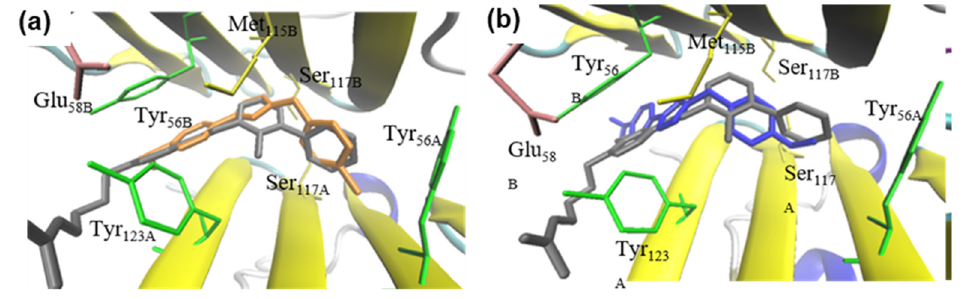
Figure 8. ( a ) Superposition of triazole 23 (orange) with BMS-202 (gray) at the PD-L1 binding site. ( b ) Superposition of triazole 20 (blue) and BMS-202 (gray) at the PD-L1 binding site.